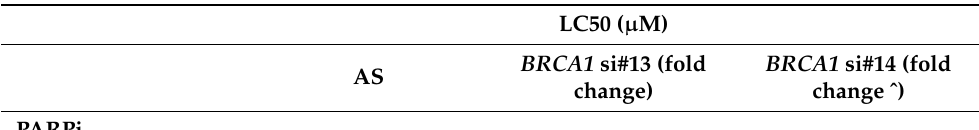
Figure 3. Down-regulation of BRCA1 decreased basal cell viability and sensitised cells to PARP inhibition. Down-regulation of BRCA1 by two distinct siRNAs (#13 and #14) in ( A ) A2780 cells and ( C ) OVCAR-3 cells decreased cell viability measured by MTS assay (N = 4; AS, AllStars control siRNA). LC50 calculated from cell viability (MTS assay) data for each of the five PARPis (talazoparib, rucaparib, olaparib, niraparib and veliparib) after BRCA1 down-regulation in ( B ) A2780 cells and ( D ) OVCAR-3 cells. * p < 0.05, ** p < 0.01. Table 3. LC50 comparisons (cell viability measured using an MTS-based assay; cell survival meas- ured using clonogenic assays) for PARPis in cell lines with down-regulated BRCA1.